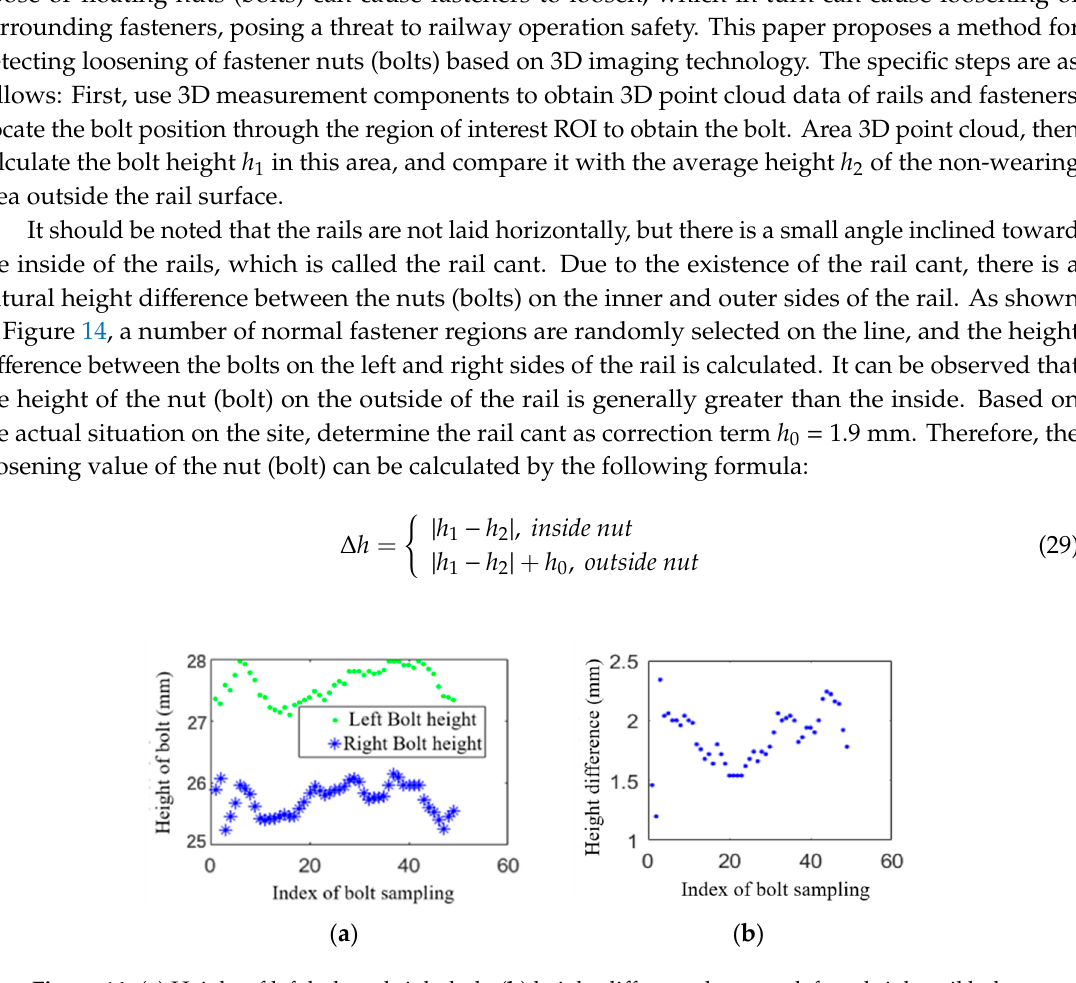
Figure 13. Example of positioning results of rail fastener area: ( a ) Two intensity maps; ( b ) Two depth maps.